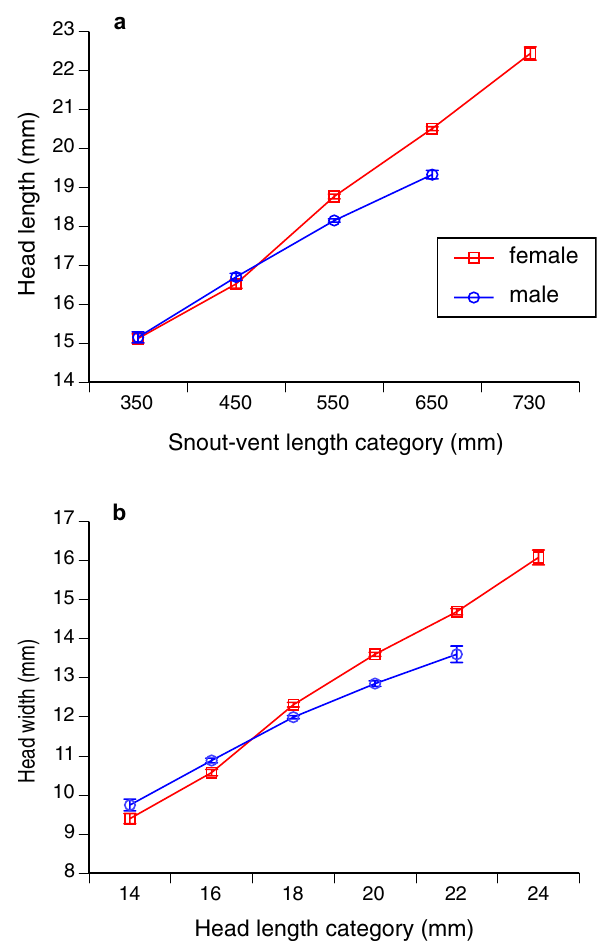
Figure 1. Sexual dimorphism in the sea snake Emydocephalus annulatus , in terms of ( a ) head length relative to snout-vent length (SVL); and ( b ) head width relative to head length. Variables on the x-axis are combined into categories to facilitate visualisation of trends; each interval of SVL or head length shows mean value and associated standard